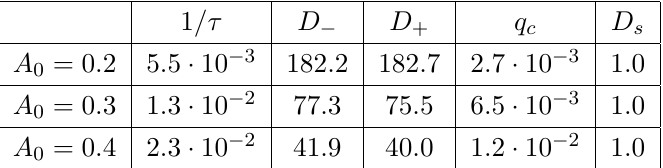
Table 1 . Parameters of the dispersion relations of the lowest